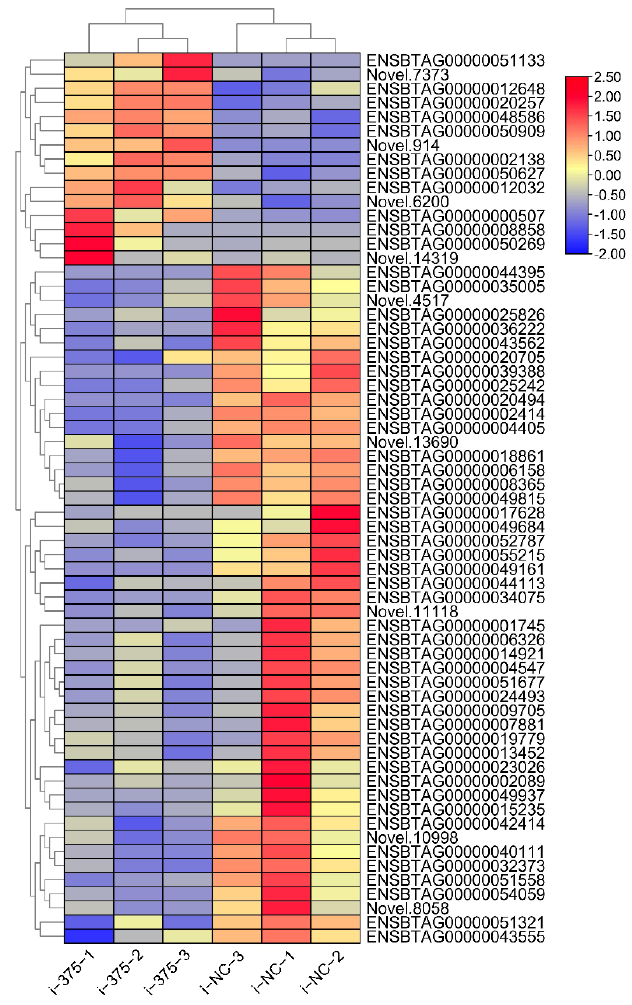
Figure 3. Cluster heat map of DIE-mRNAs between the miR-375 inhibitor and inhibitor NC groups.